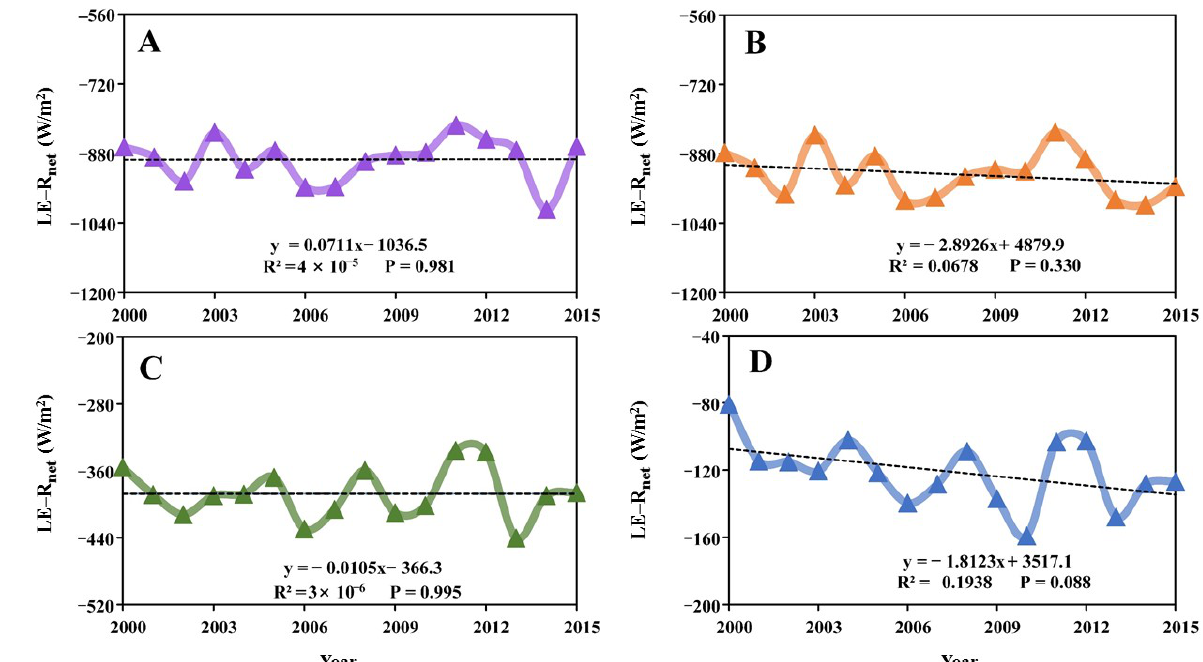
Figure 18. Trend of LE-R net from 2000 to 2015 (( A ) Jinan City, ( B ) Zhengzhou City, ( C ) Lanzhou City, ( D ) Xining City).